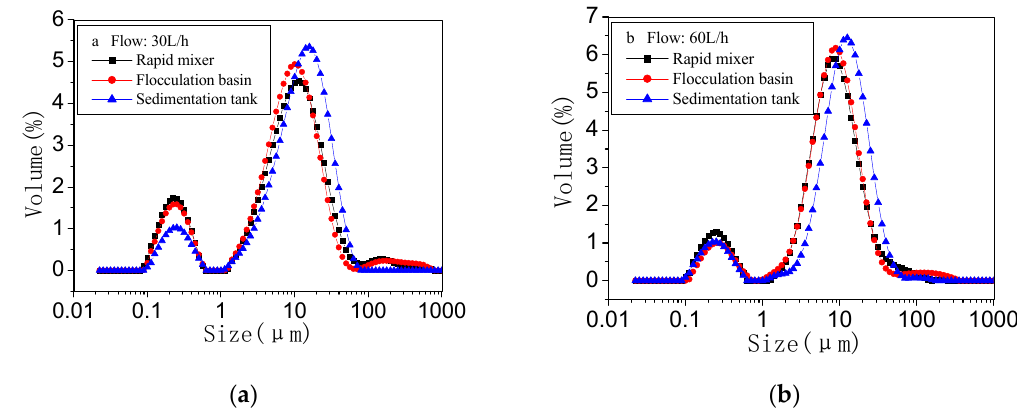
Figure 4. Floc size distribution with different flows for three stages. ( a ) 30 L/h; ( b ) 60 L/h.